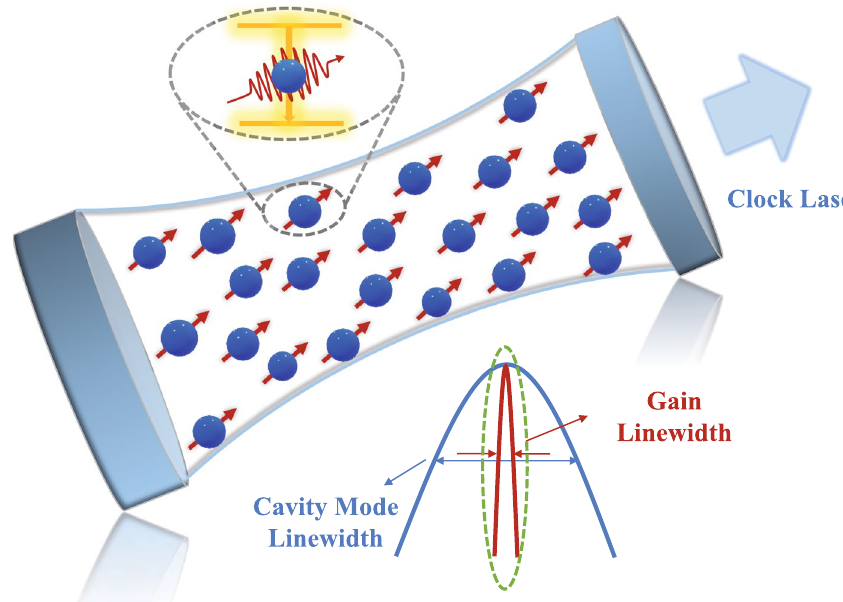
Fig. 2 Schematic diagram of an AOC. Due to the high phase coherence of collective atomic dipole, the stimulated radiation can be used as optical frequency standard directly. AOC works in bad-cavity region, and the gain linewidth is much smaller than the cavity-mode linewidth, so the center frequency of output laser depends on quantum transition frequency, which can effectively suppress the cavity-pulling